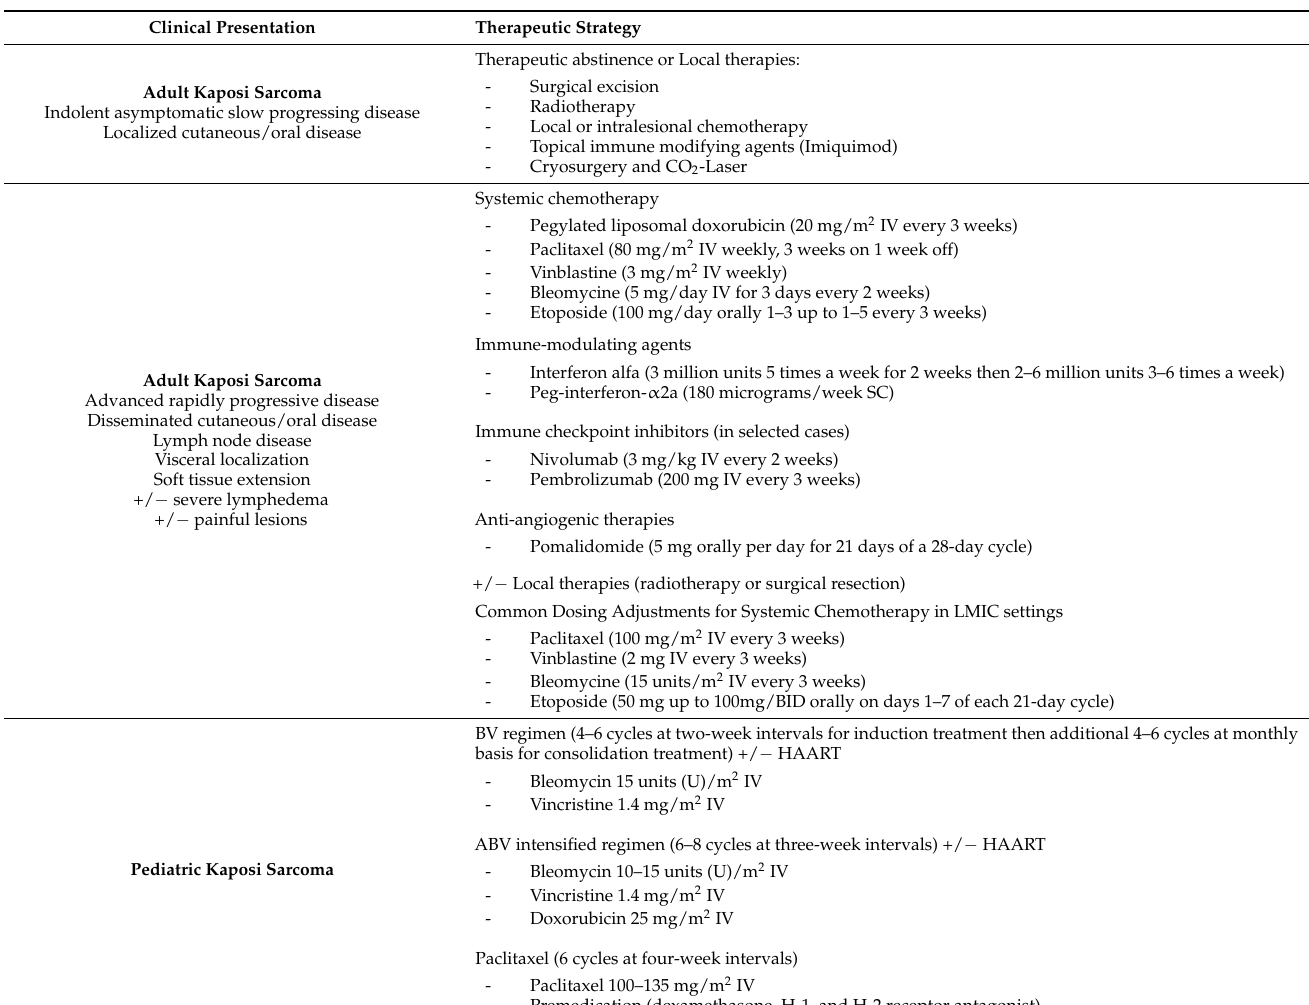
Table 1. Therapeutic options for Kaposi sarcoma in terms of patients’ clinical